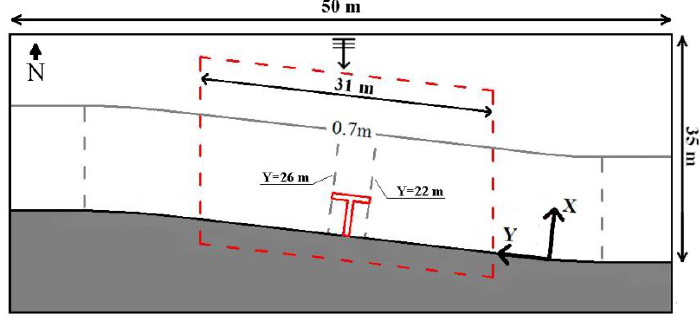
Figure 3. Plan view of the computational domain. Dashed line: domain used in the experimental test.